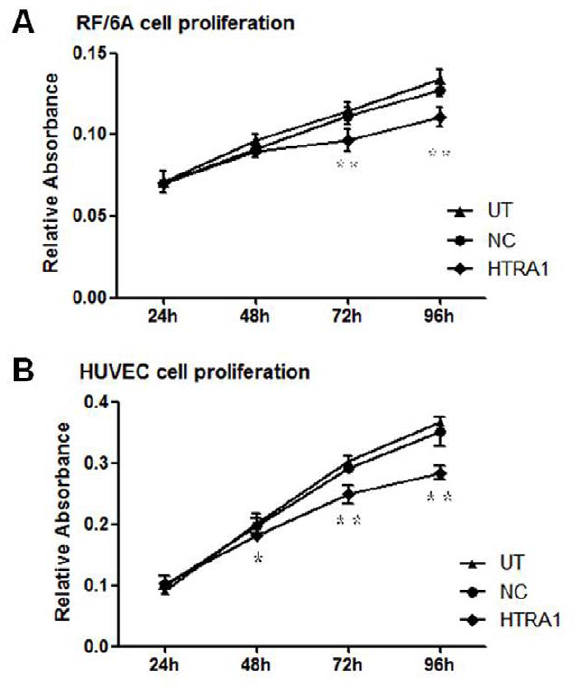
Figure 3. Effect of HTRA1 on the proliferation of RF/6A cells and HUVECs. Proliferation of RF/6A cells (A) and HUVECs (B) was measured with an MTT assay at 24, 48, 72 and 96 h. The values are listed as the means 6 SD of at least three independent experiments. Compared with the control groups, RF/6A cell proliferation was reduced by 7% at 48 h and this reduction peaked at 17% on the fourth day (**p , 0.01); HUVEC proliferation was reduced by 10% (*P , 0.05) at 48 h, and this reduction peaked at 23% (**P , 0.01).